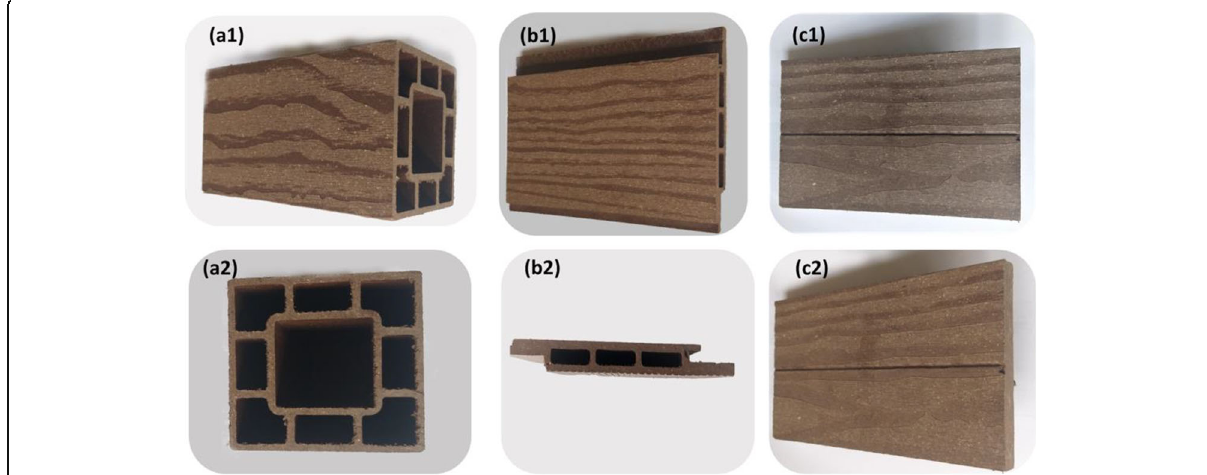
Fig. 8 Extruded profiles for floors and construction uses overview (a1-c1) and profile view